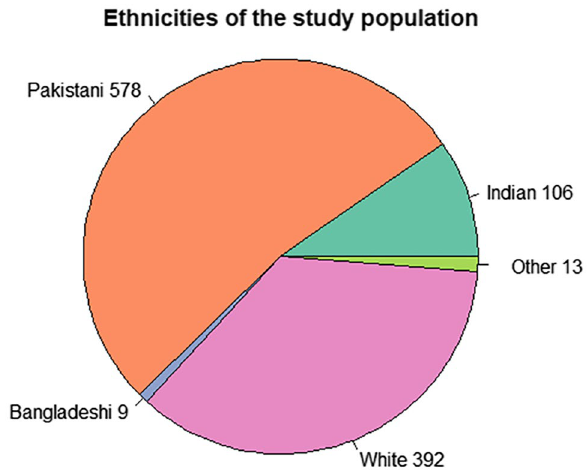
Figure 1. Ethnicities of the participants included in the statistical analyses of the study. Majority of the individuals are Pakistani and White Europeans, followed by Indian, and then Bangladeshi participants.